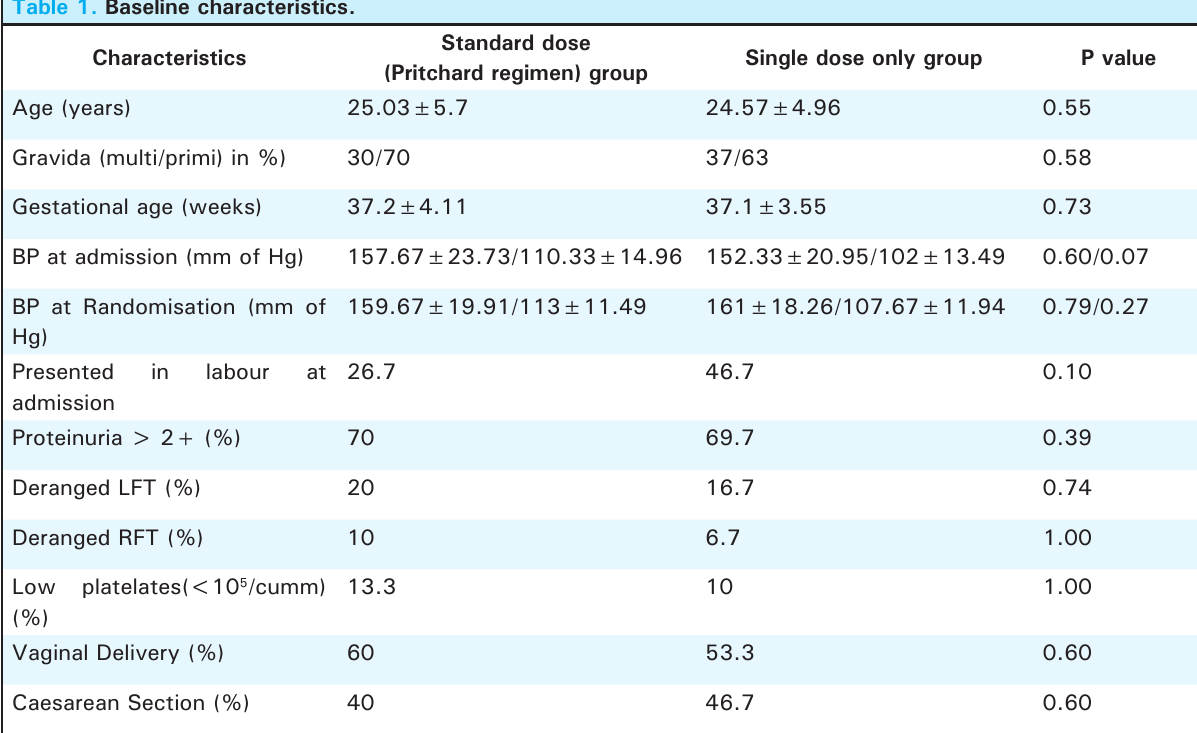
Table 1. Baseline